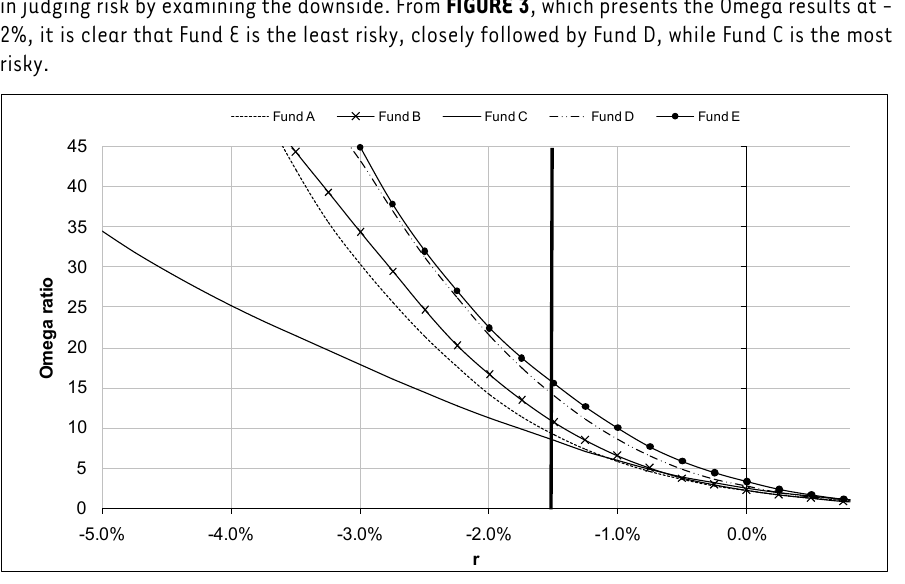
Comparative ranking results (Omega) RANKING PDI Omega Residual Variance